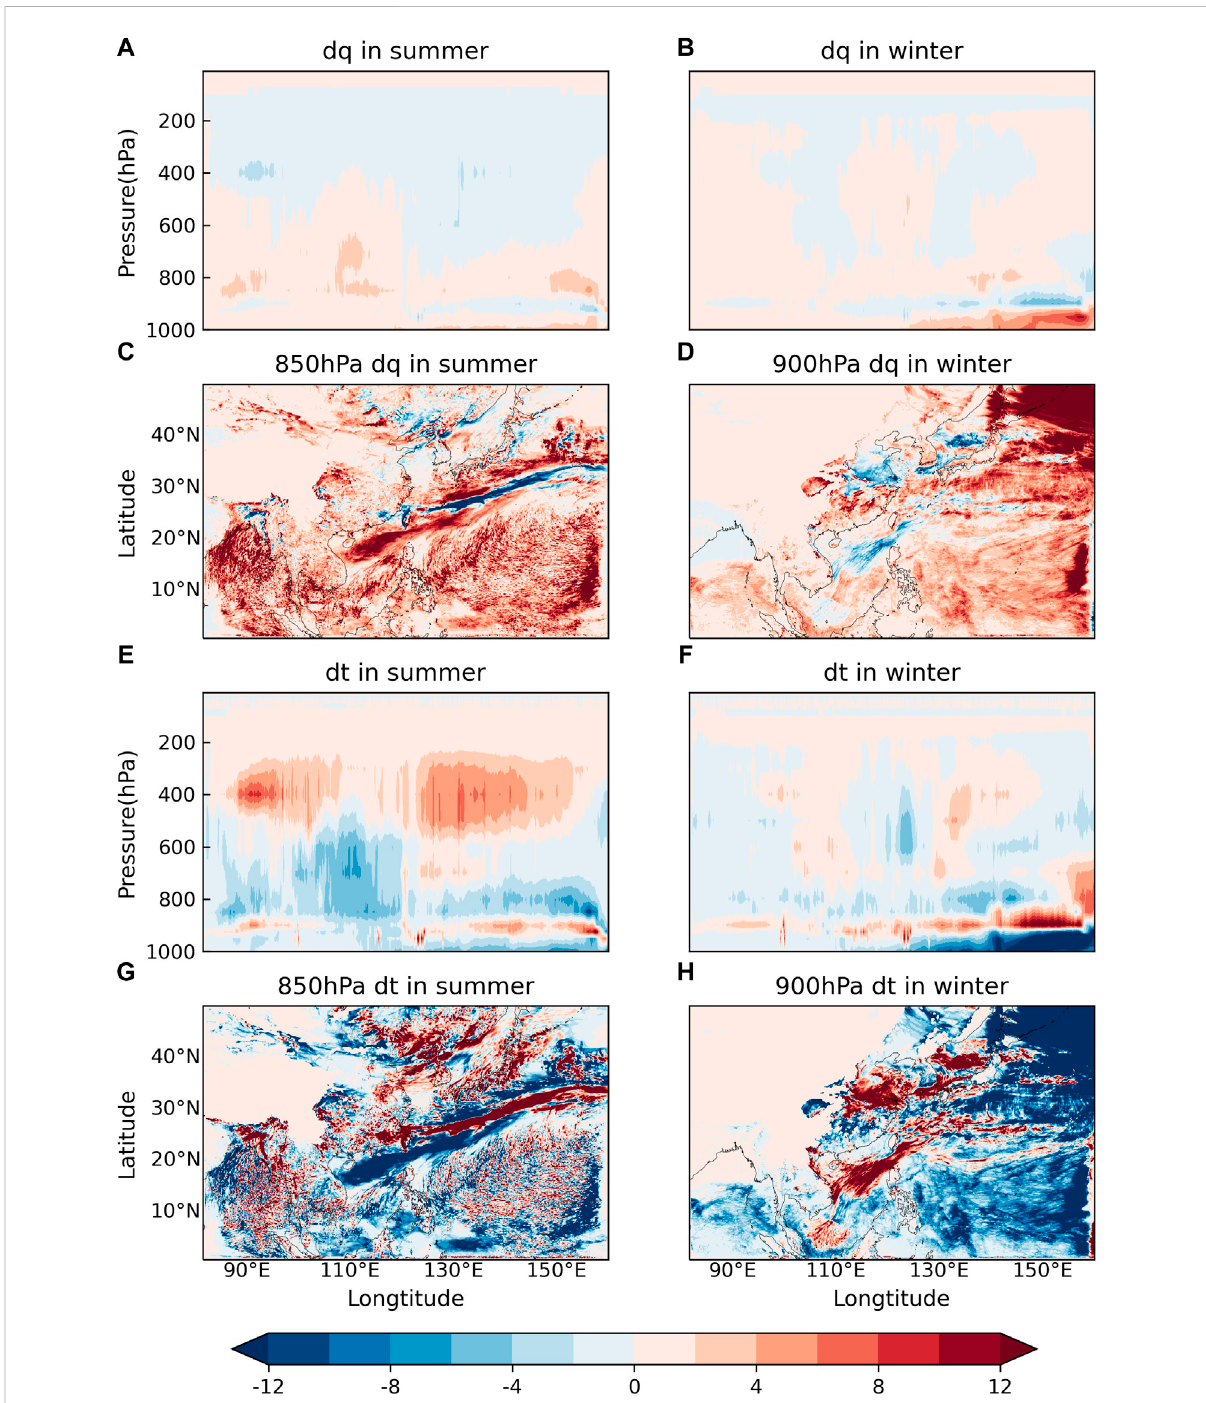
FIGURE 7 Vapour and temperature tendencies of the cloud microphysical process. (A – D) Vapour tendency (10 – 3 g/kg). (E – H) Temperature tendency ( ° C). (A,E) Latitudinal average cross-section in the summer. (B,F) Latitudinal average cross-section in the winter. (C) 850 hPa in the summer. (D) 900 hPa in the winter. (G) 850 hPa in the summer. (H) 900 hPa in the